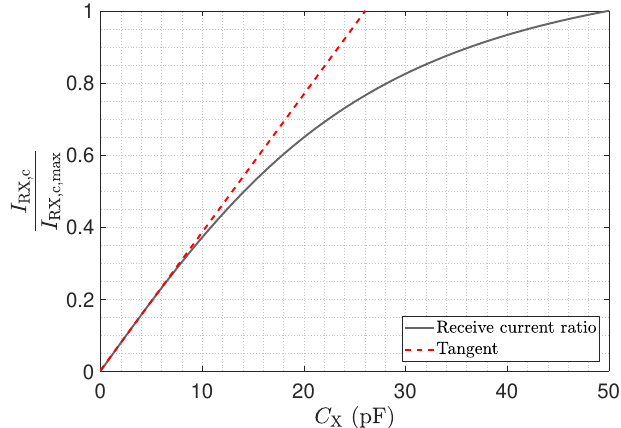
Figure 8. Normalized received current of the LCR circuit shown in Figure 4c for an excitation frequency of 40MHz, as a function of the inter-electrode capacitance C X . The tangent indicates the ideal linear